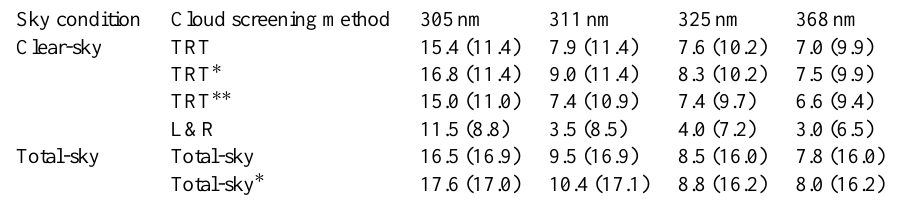
Table 2. Averaged relative mean biases ( RM ) and the relative deviation ( RD , in parenthesis) at 305, 311, 325, and 368nm across all 27 sites under clear-sky and total-sky conditions ( ∗ excluding the remote and clean sites, NM02, AZ02, and CO12, ∗∗ excluding sites CA22, FL02, GA02, and ON02 to be compared with the results of L&R).